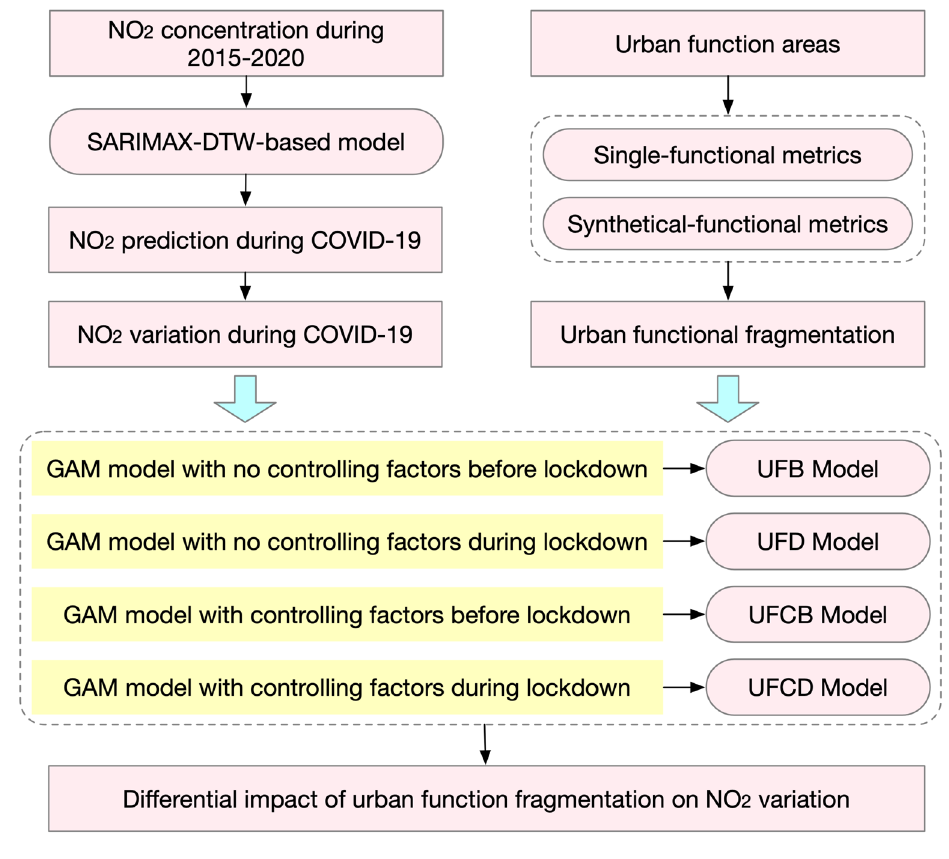
Figure 1. The overview framework. Three components are involved, SARIMAX-DTW-based model for NO 2 variation estimation, human-activity-driven urban functional fragmentation quantification and UFB, UFD, UFCB and UFCD Models for association analysis.